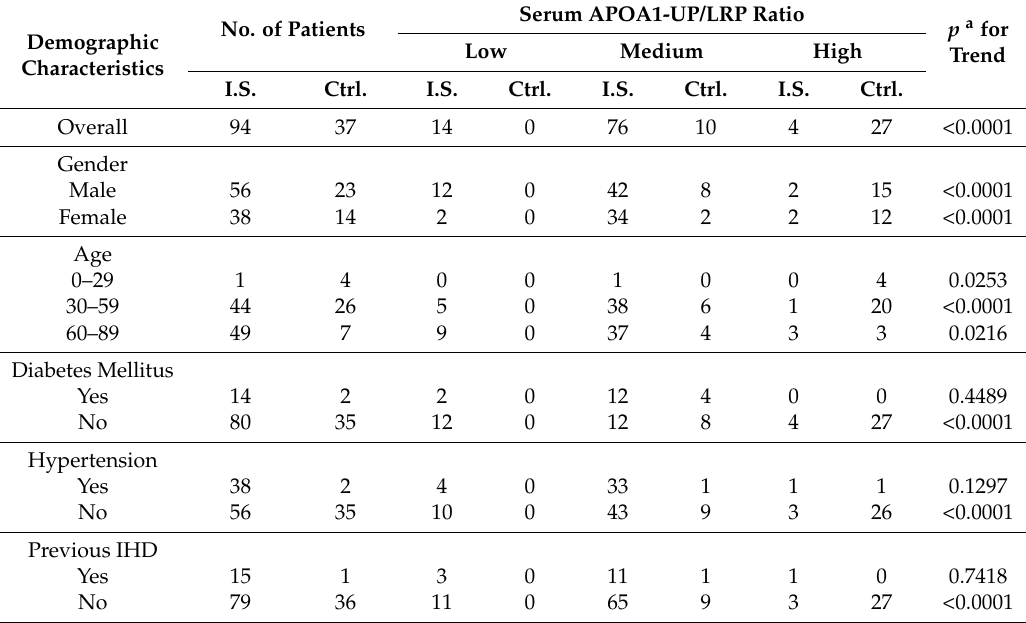
Table 2. Case number of patients across categories of serum APOA1-UP level, stratified by age, diabetes mellitus, hypertension, and previous ischemic heart